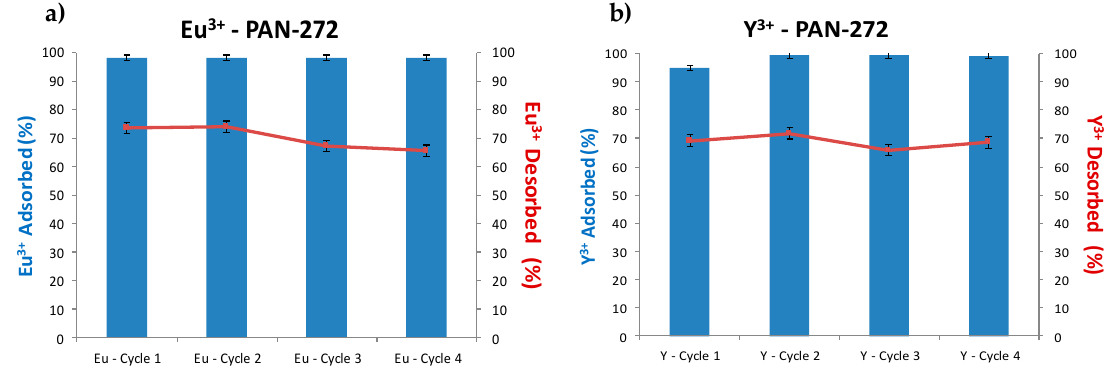
Figure 10. Adsorption–desorption cycles of ( a ) Eu(III) and ( b ) Y(III).